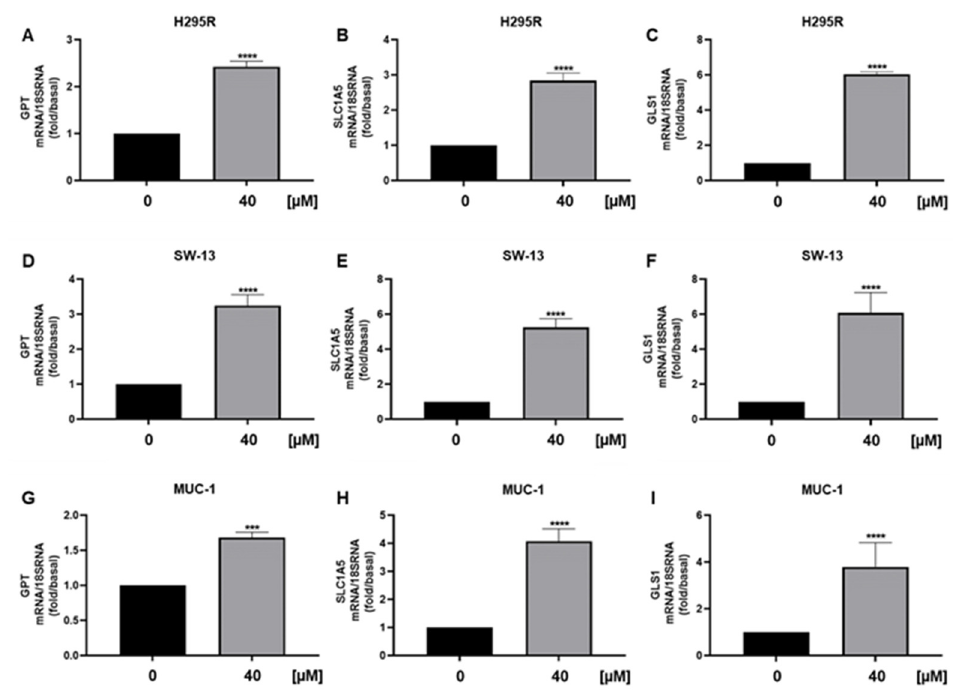
Figure 9. Curcumin effects on glutamine metabolism in ACC cell lines. Real ‐ time RT ‐ PCR for GPT, SLC1A5, GLS1 gene expression in H295R cells ( A – C ), SW ‐ 13 cell ( D – F ) and MUC ‐ 1 cells ( G – I ) treated with curcumin (40 μ M) for 24 h. Data represent the mean ± SE of values from at least three independent RNA samples (*** p < 0.001; **** p < 0.0001 vs. 0 μ M).